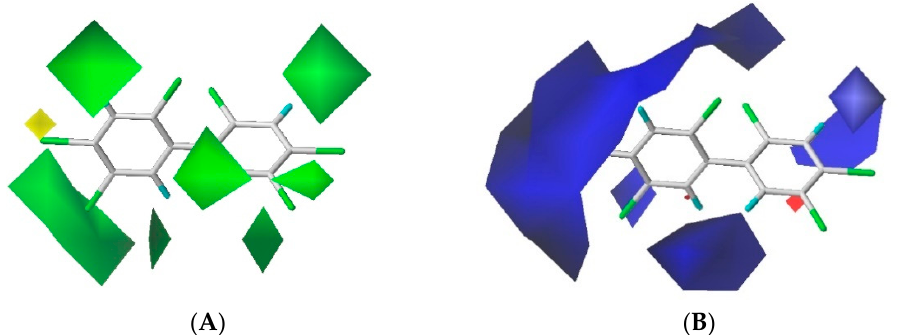
Figure 2. The contour maps of steric ( A ) and electrostatic field ( B ) of the combined activity comparative molecular field analysis (CoMFA) model.